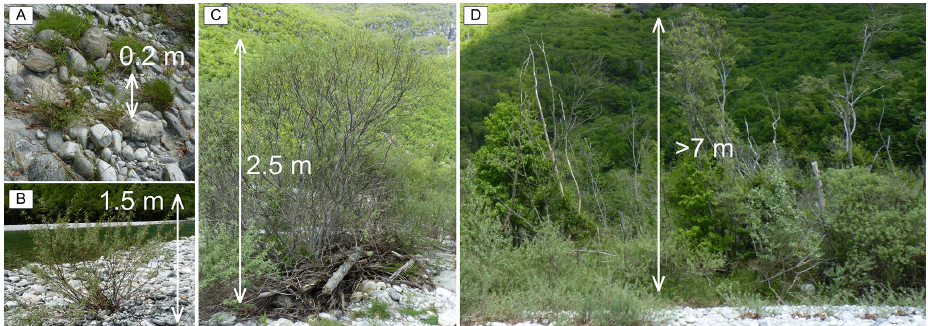
Figure 2. Typical vegetation composition of the Maggia floodplain. From left: gravel bar detail with (a) small herbaceous plants (inner zone of the main bar); (b) taller 1–3-year-old Salix saplings (upstream part of the main bar); (c) 2–3m tall Salix trees which range up to 5–6 years in age (middle of the main bar); (d) tall Salix , Populus and Alnus trees which have been found to be up to 20 years in age (middle/downstream of the main bar close to the main channel, zone with the highest vegetation density). Flood debris is visible at the stems of larger trees.